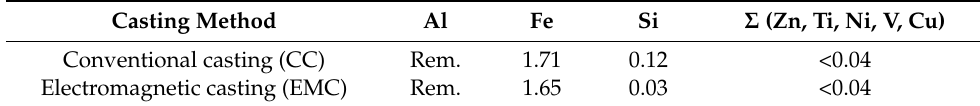
Table 1. Chemical composition of Al–1.7Fe alloys (wt.%). Casting Method Al Conventional casting (CC)